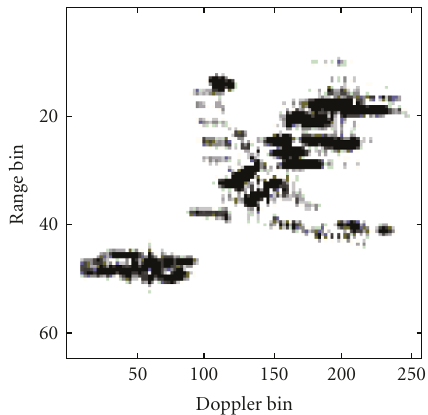
Figure 5: ISAR images of simulated data based on the range- Doppler